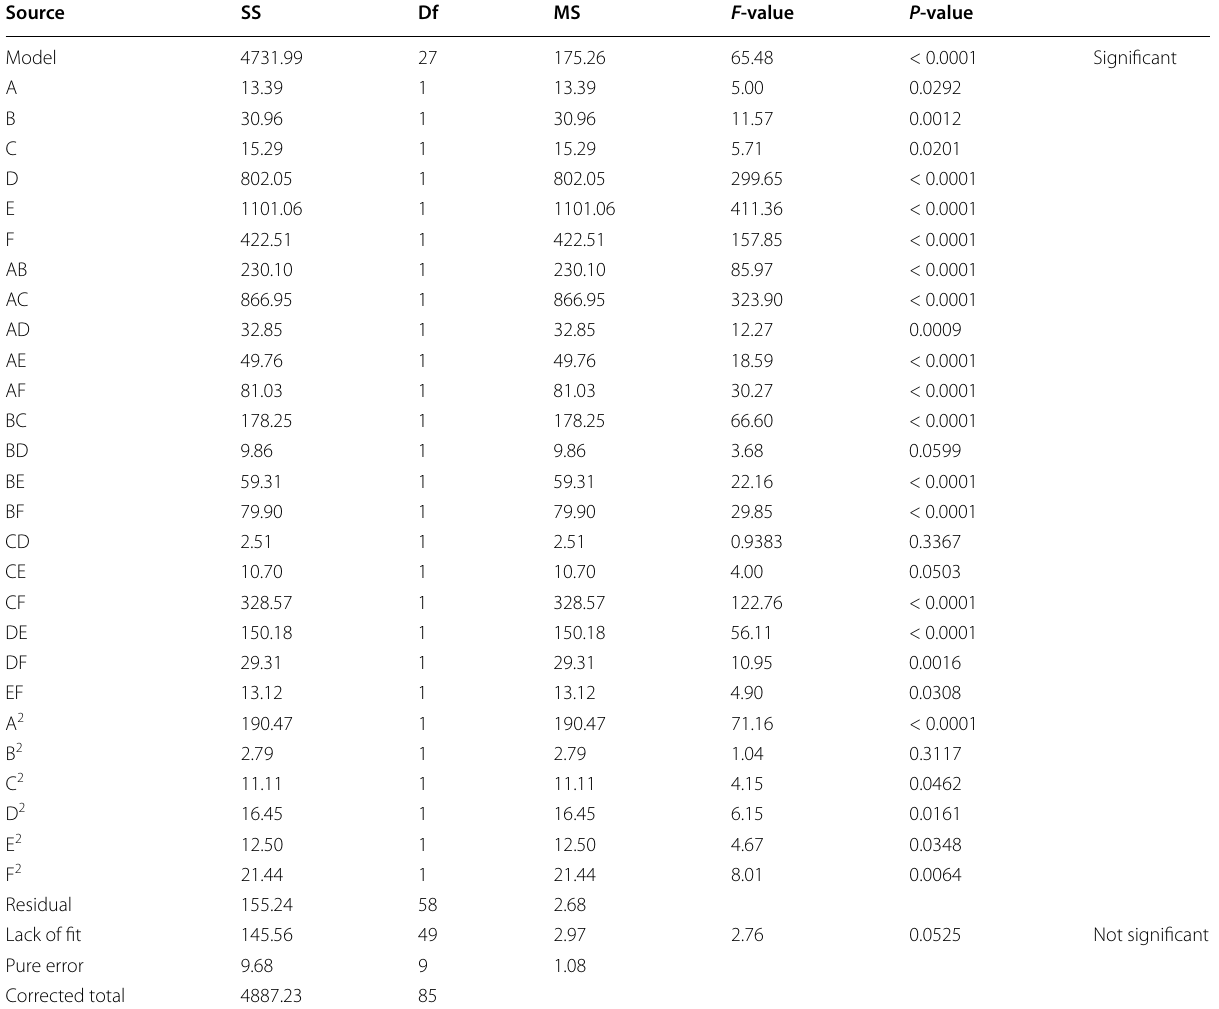
Table 2 Analysis of variance for response surface of quadratic model for the CCD experiments